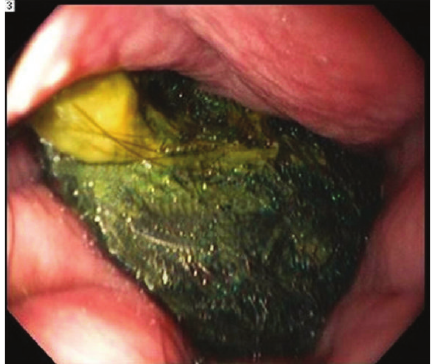
Figure 3: Endoscopic image of bezoar in stomach causing complete occlusion of duodenum.